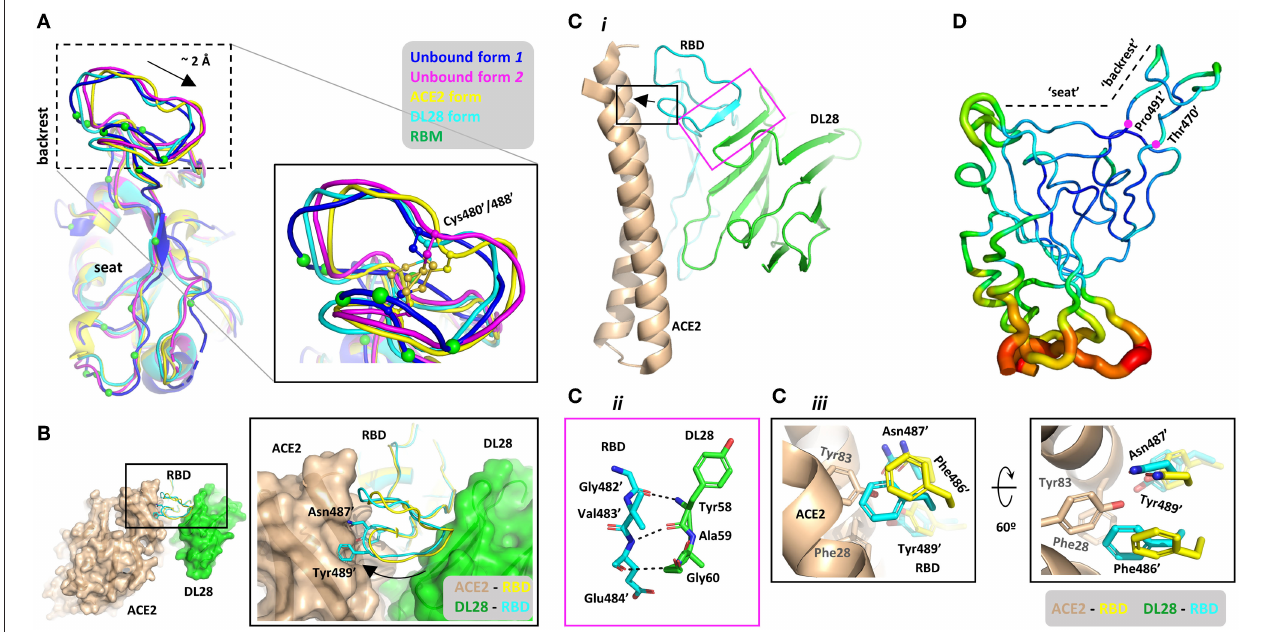
FIGURE 5 | Structural basis for the proposed “conformation competition” mechanism for the ACE2-blocking activity of DL28. (A) Comparison of the RBD conformations at the RBM between two unbound forms (blue, magenta), the ACE2-bound ( Lan et al., 2020) form (yellow), and the DL28-bound form (cyan). The ACE2-interacting residues are shown as green C α spheres. (B) Alignment of the DL28-RBD structure (green surface and cyan ribbon) with the ACE2-RBD structure (Lan et al., 2020; wheat surface and yellow ribbon). DL28 pushes the boxed loop in (A) toward ACE2, causing clashes between two aromatic residues and the RBD-interacting α -helices in ACE2. (C) Both ACE2 and DL28 use a rigid structure to interact with the boxed loop in (A) , making a compromise unlikely to reach. The black box highlights the clash between ACE2 (wheat) and the DL28-bound form of RBD (cyan). The clashing RBD residues in the ACE2-bound form are shown as yellow sticks. The magenta box highlights the interaction between DL28 and the “backrest” region mediated by main-chain interactions. (D) C α b-factor distribution shown in putty representation using a rainbow ribbon with a radius that increases from the lowest (61.6 Å 2 ; dark blue) to the highest (170.0 Å 2 ; red) B-factor. The average B-factor of the “backrest” region (residue 470–491) is 76.59 Å 2 which is lower than that of the whole chain (97.5 Å 2 ), suggesting relative inflexibility.